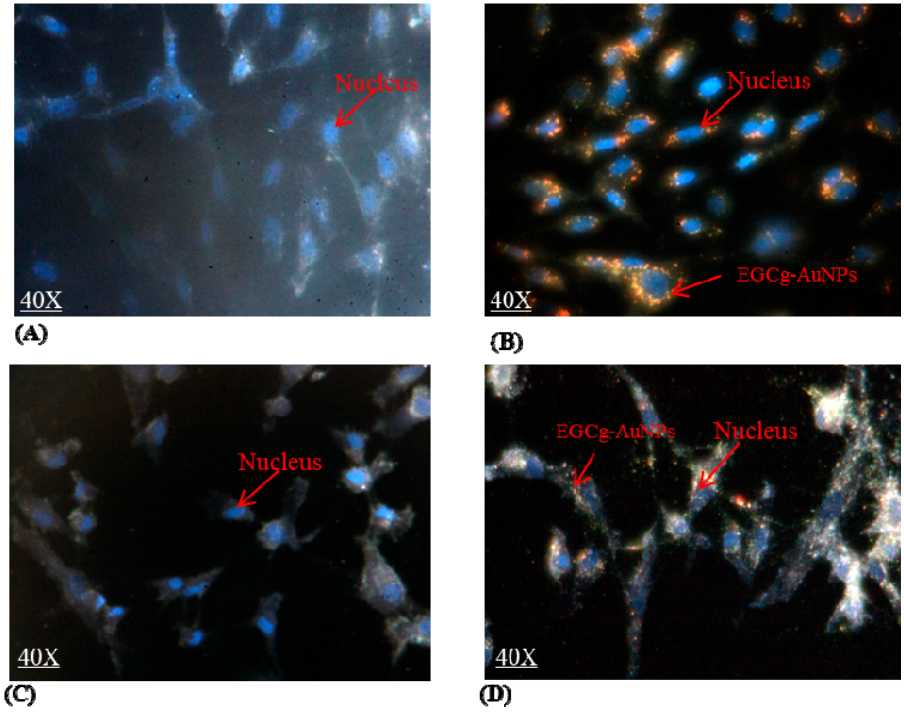
Figure 2. Cellular internalization of EGCg gold nanoparticles; images were captured via Cyto Viva dark field microscope. ( A ) human umbilical vein endothelial cells (HUVECs) untreated; ( B ) HUVECs treated with EGCg-AuNPs 20 μ g/mL; 2 h; ( C ) human coronary artery smooth muscles cells (HCASMCs) untreated; ( D ) HCASMCs treated with EGCg-AuNPs 20 μ g/mL; 2 h. HUVECs: Human umbilical vein endothelial cells, HCASMCs: Human coronary artery smooth muscle cells. Images were captured at 40× magnification.